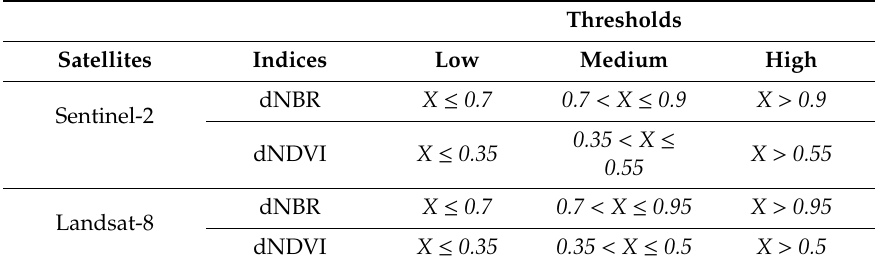
Table 4. Thresholds for each satellite and index in Pontevedra fire.